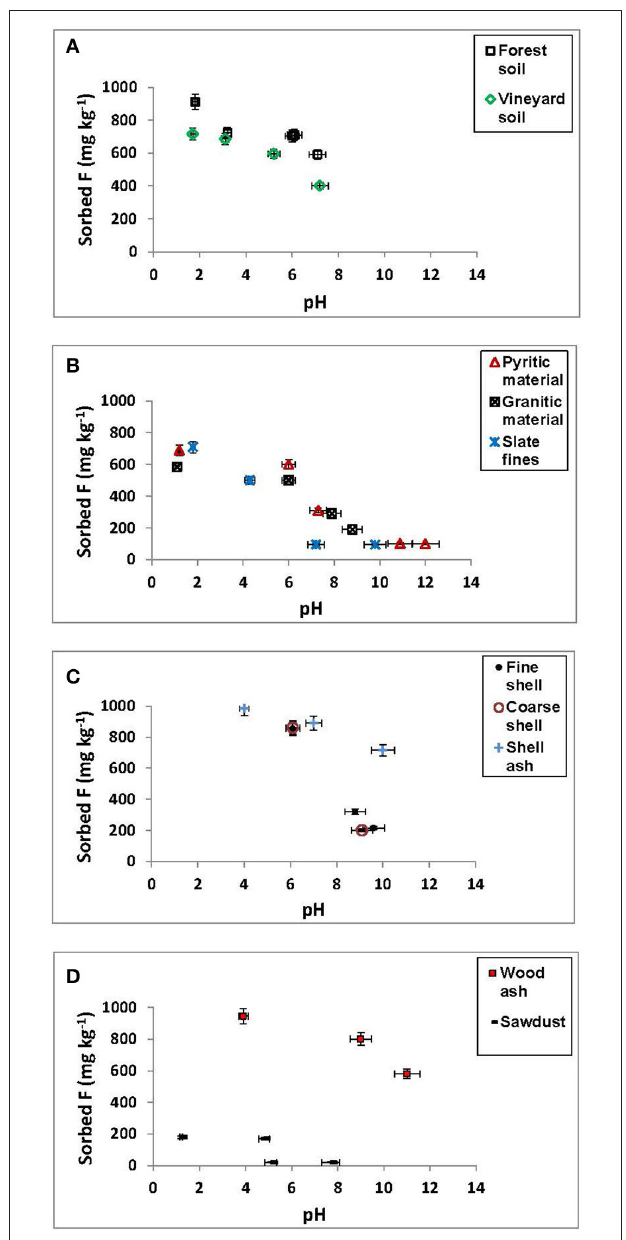
FIGURE 1 | Sorption results (mg kg − 1 ) for F − on the soils, by-products and waste materials studied, at different pH values. Average values (three replicates), with coefficients of variation <